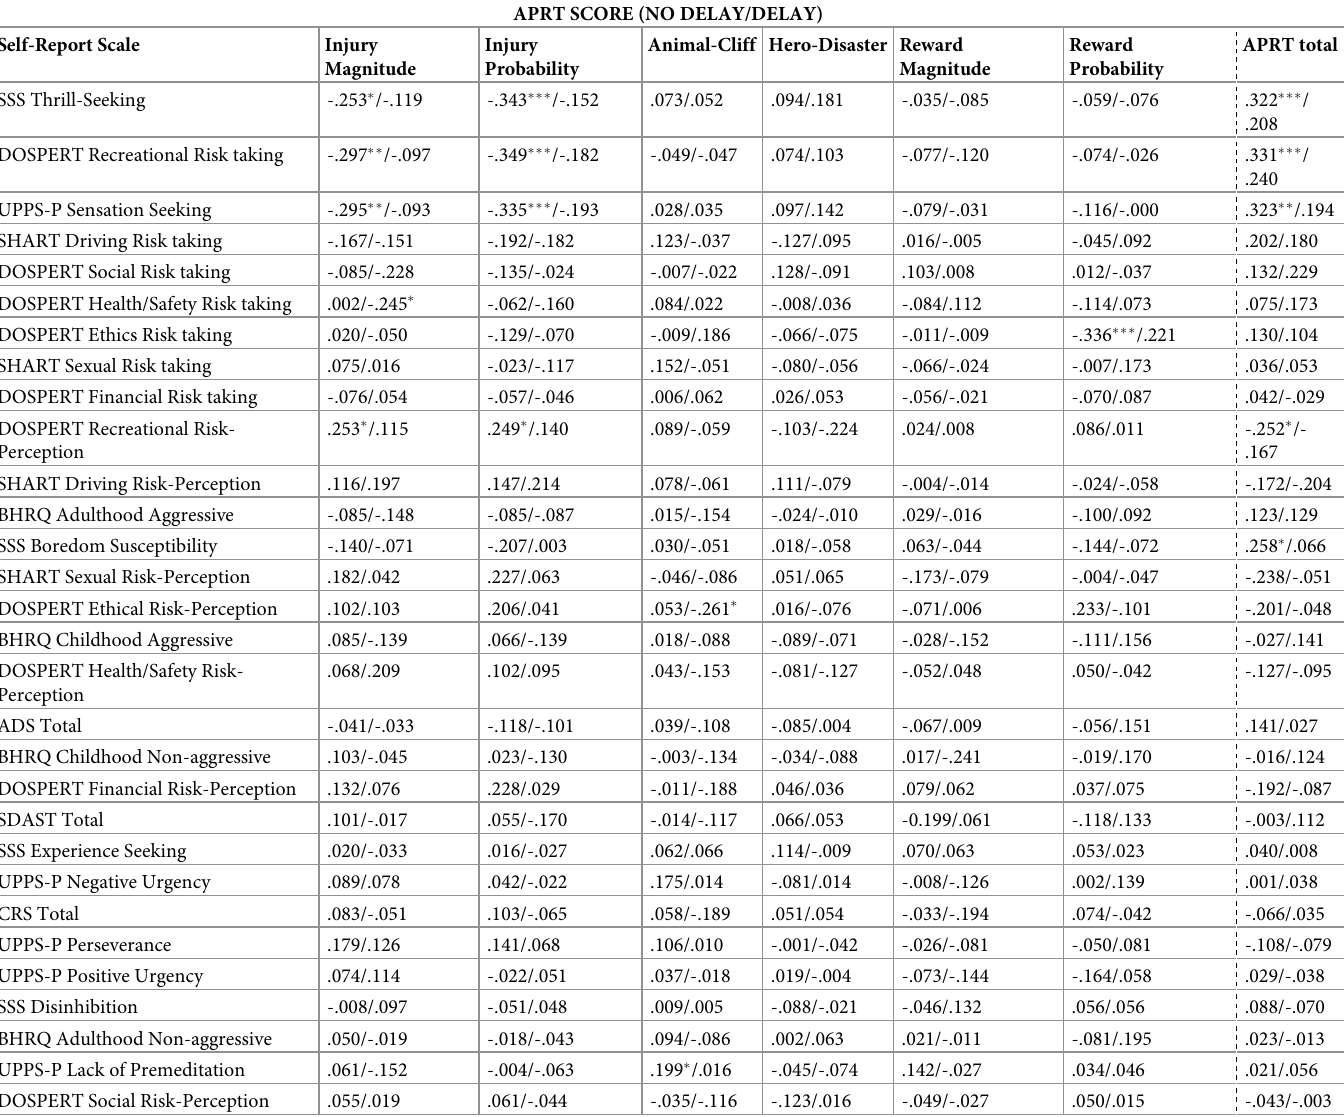
Table 4. Pearson correlations between APRT Go Presses scores and self-report measures by delay